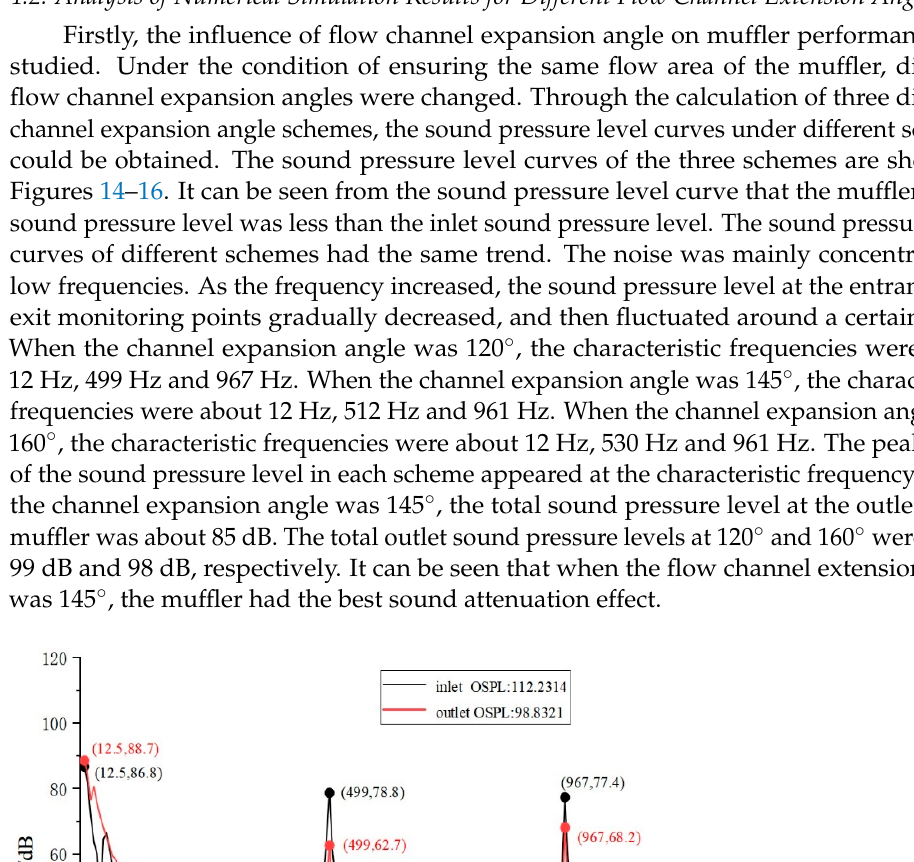
Figure 13. Sixth-order acoustic cavity modality.